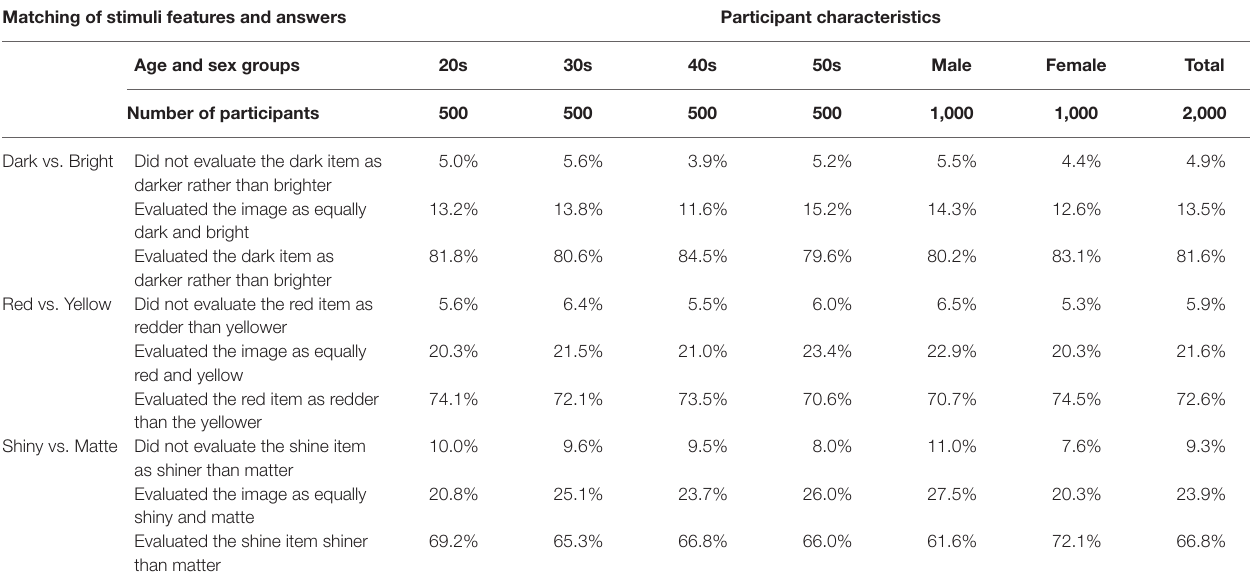
TABLE 2 | The rates of inversely matching physical features to perceptual evaluations in the Online2. Matching of stimuli features and